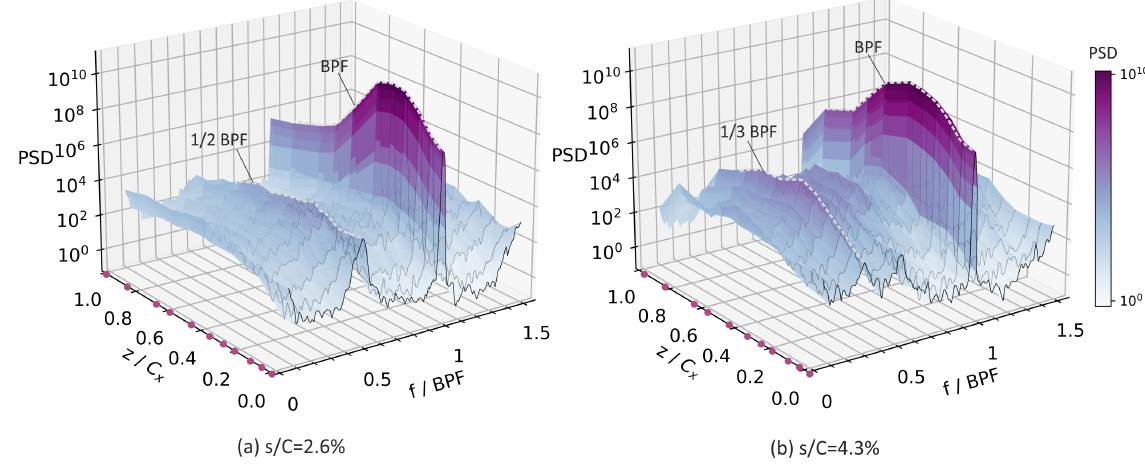
Figure 8. PSD of wall pressure at various axial positions in EXP ( s / C = 2.6% at Φ = 0.50; s / C = 4.3% at Φ = 0.51; presented in the stationary frame; dots on z -axis and solid lines corresponding to locations of Kulite sensors).